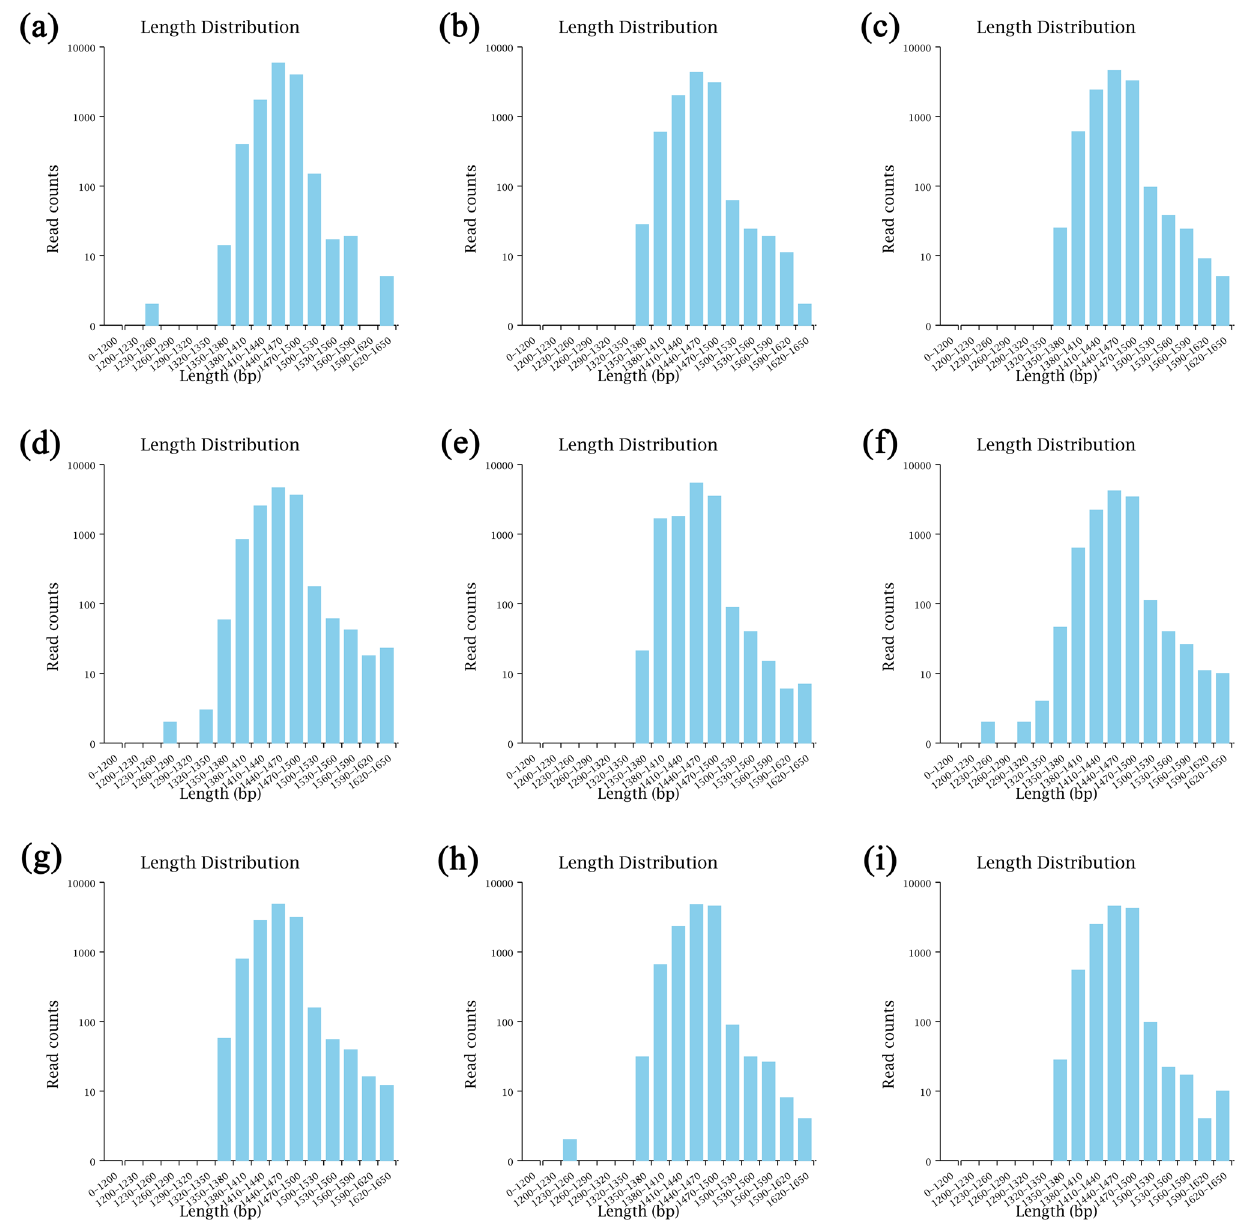
Figure 1. The number of sequences within the corresponding length range in each sample after quality control filtration. ( a – c ) for CK; ( d – f ) for SF; ( g – i ) for